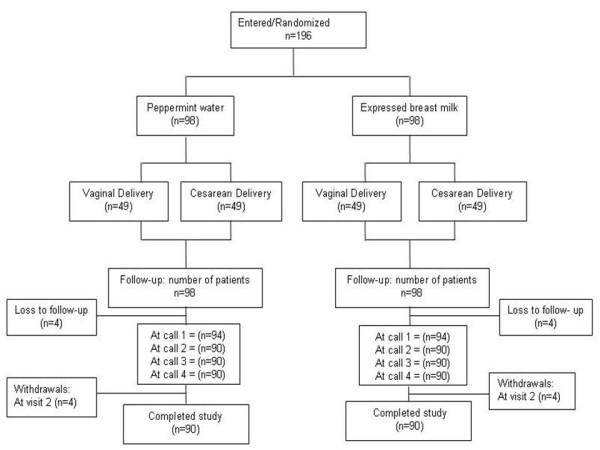
Flow of the study participants.